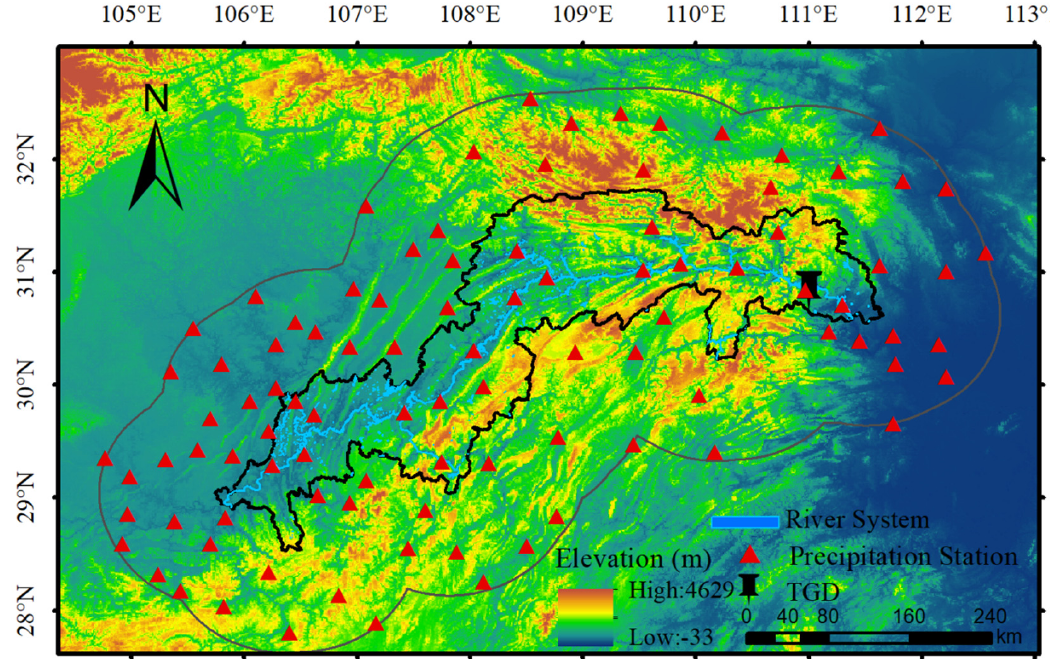
Figure 1. Study area with terrain. Black pin marks the Three Gorges Dam (TGD); the thick black line delineates the boundary of the Three Gorges Reservoir Area (TGRA); the thin black line represents the 1° buffer of the TGRA. Meteorological stations used in this study located within 1° buffer of the TGRA are marked as red triangles.